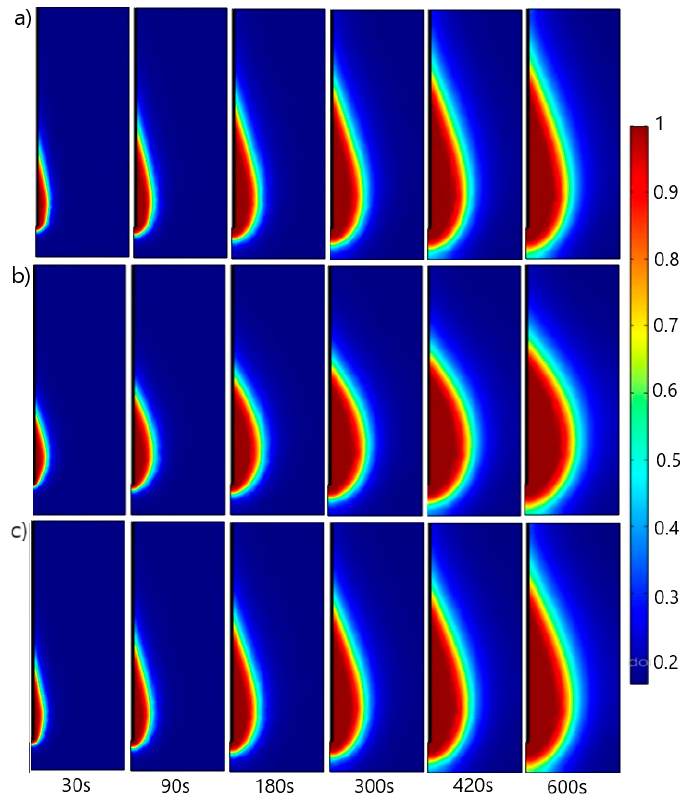
Figure 8. The time evolution of the fraction of damage of the tissue exposed to 2.45 GHz. Calculations were performed using dielectric constants for ( a ) inflated lungs [52], ( b ) deflated lungs [52], and ( c ) values taken from [53,54].